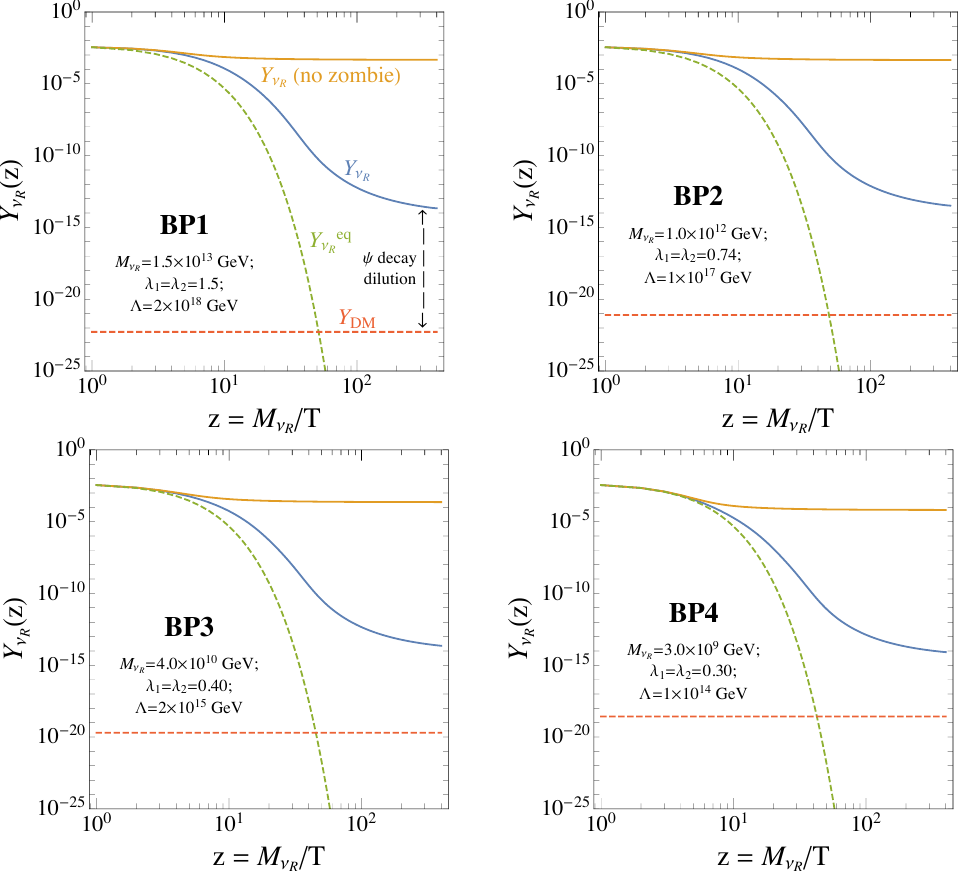
and Y eq are shown ν R R R